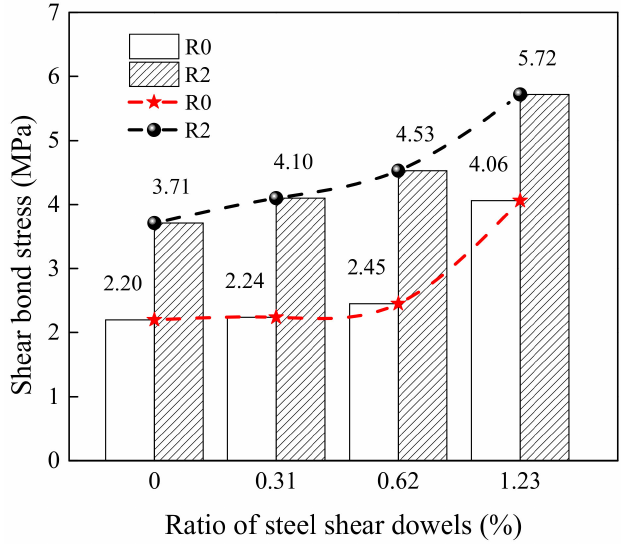
Figure 12. Effect of ratio of steel shear dowels on shear bond